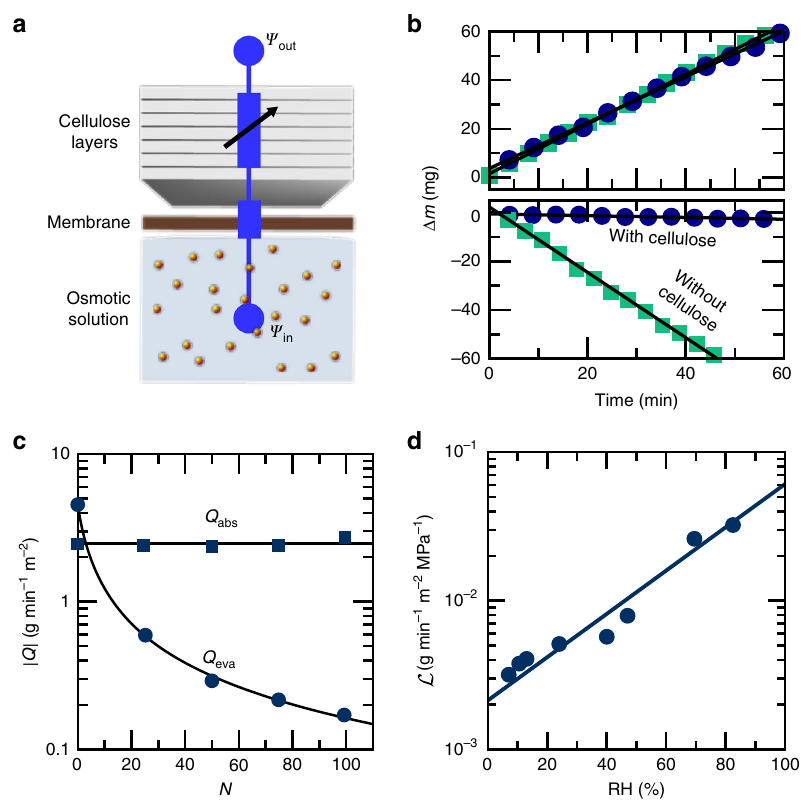
Fig. 5 Water transport asymmetry in a biomimetic trichome. a Diagram of the biomimetic system with the composite membrane made of a semipermeable membrane (Sterlitech SW30-HR) and the cellulose layer (paper sheets). A 1 M NaCl solution is enclosed behind this composite membrane. b Water absorption (top) and evaporation (bottom) of a biomimetic trichome in the presence (circle) and absence (square) of a cellulose layer ( Δ m ¼ m ð t Þ (cid:2) m ð 0 Þ ) (RH = 50%). c Absolute value of the absorption (squares) and evaporation (circles, at RH = 50%) rates of the biomimetic composite membrane, as a function of the number N of 100 μ m-thick sheets of paper. d Effect of relative humidity on the effective water vapor conductance L of the biomimetic trichome prepared from 20 paper